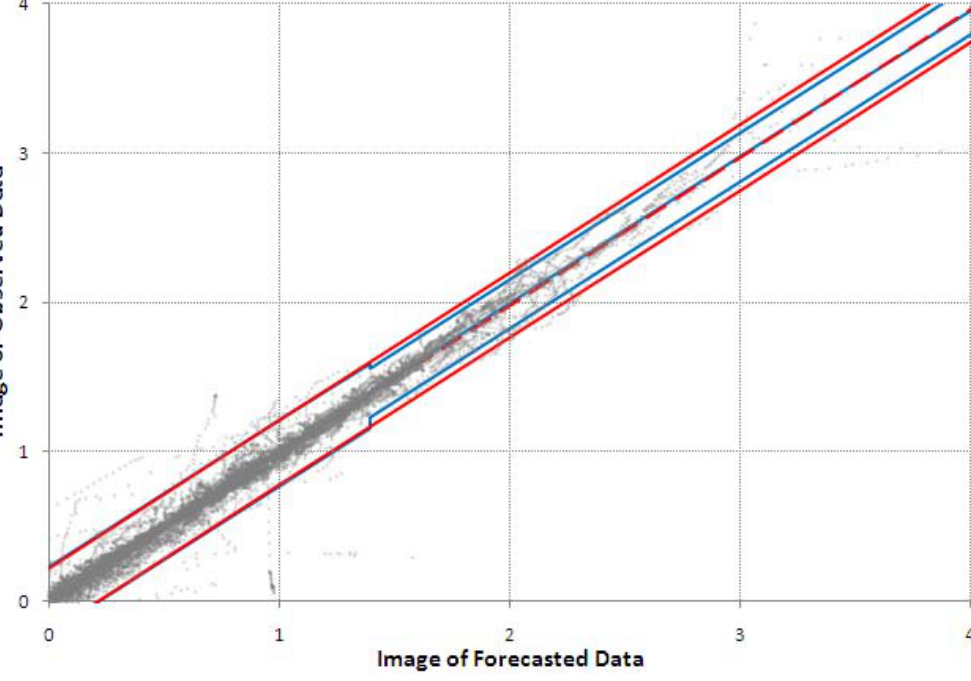
www.hydrol-earth-syst-sci.net/15/3253/2011/ Hydrol. Earth Syst. Sci., 15, 3253–3274,